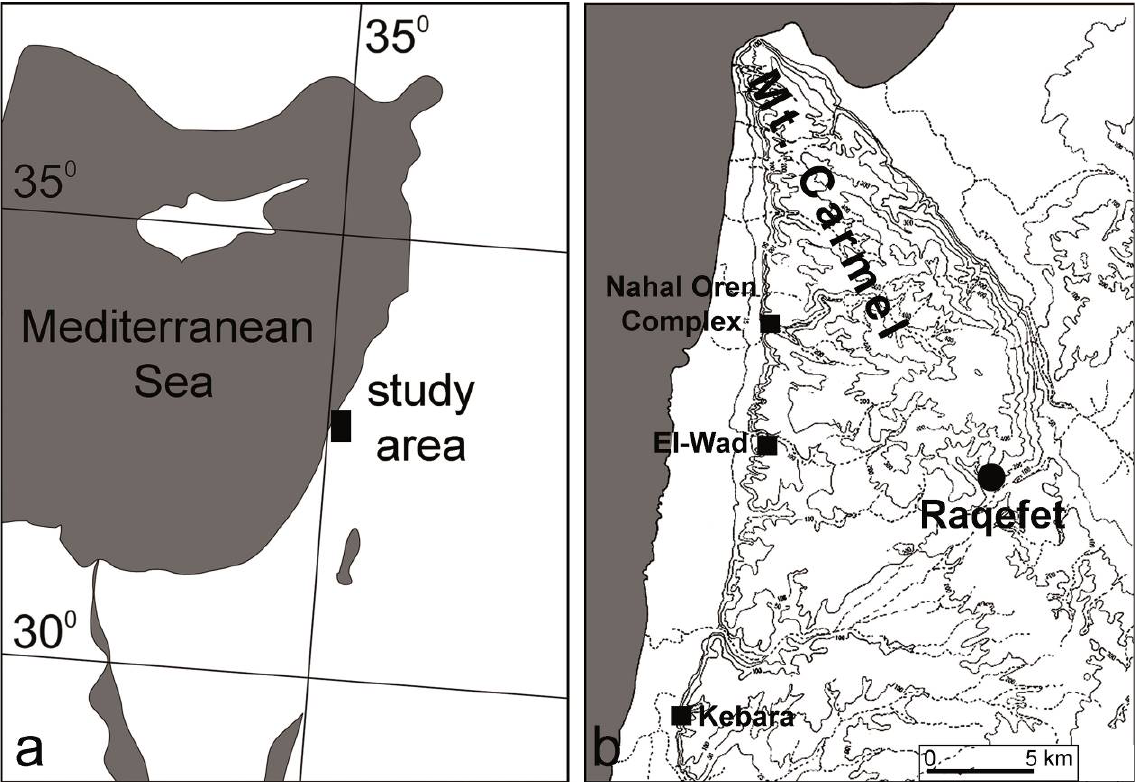
Figure 1. Location map of Natufian sites in Mt. Carmel,